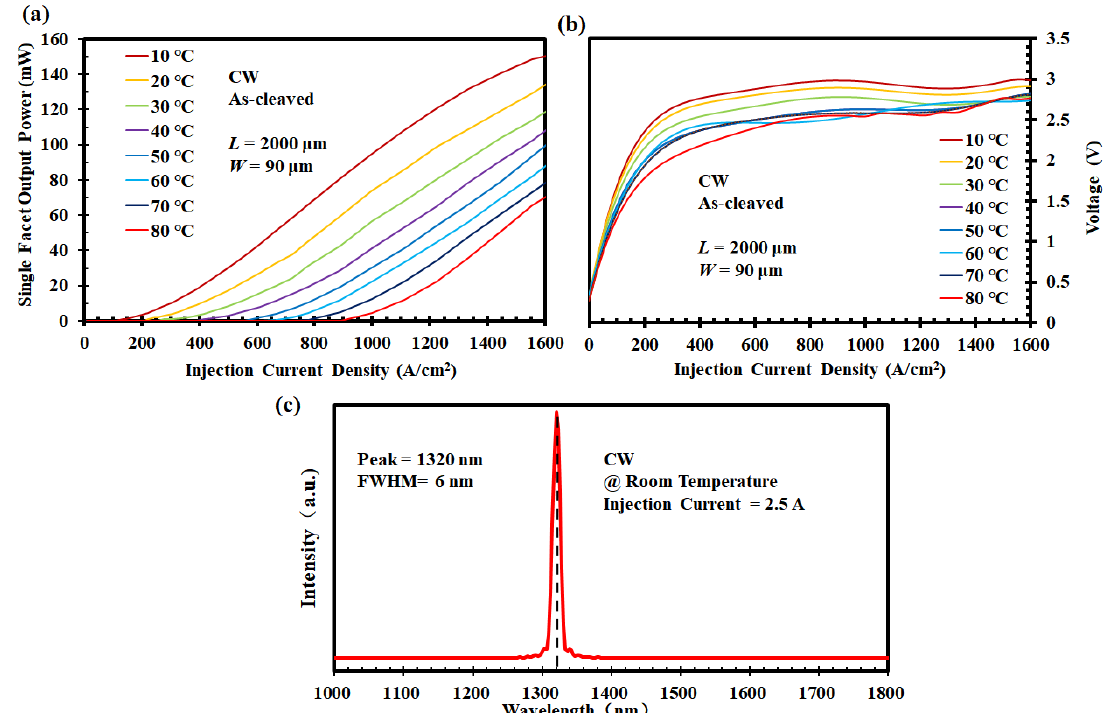
Figure 7. Characteristics of Si-based InAs/GaAs QD laser: L-I-V test ( a ) light output power versus injection current density under different temperatures; ( b ) V-I curves under different temperatures; and ( c ) lasing spectrum of Si-based InAs/GaAs QD laser at room temperature with emission at 1320 nm.